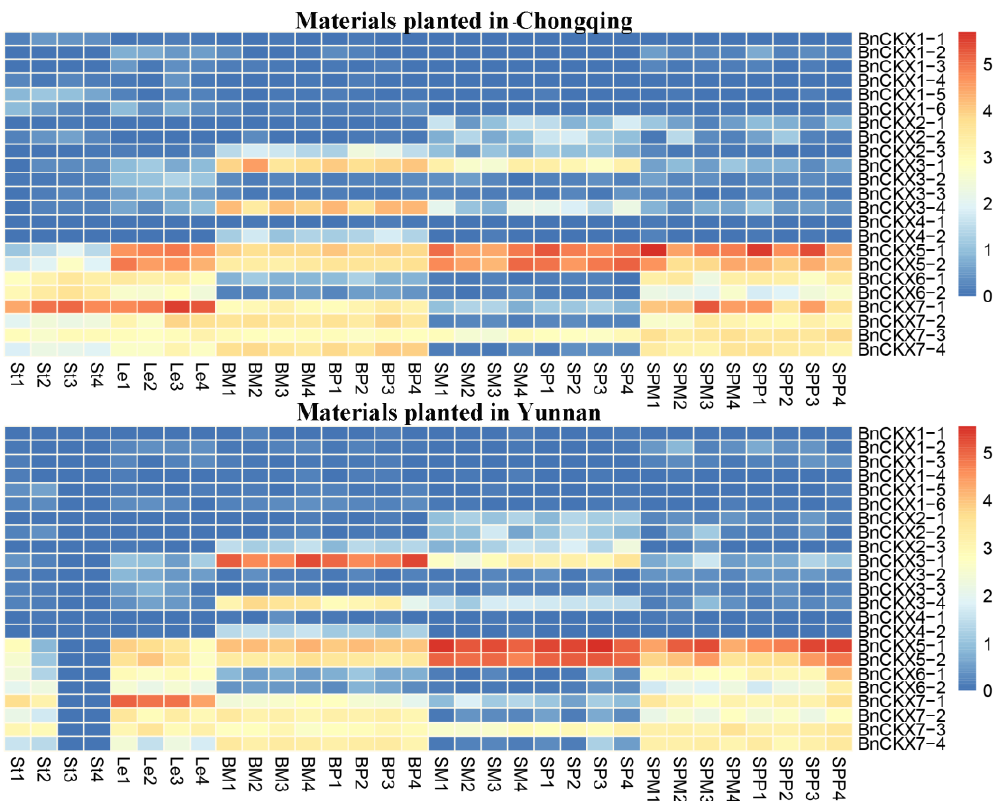
Figure 5. Heatmaps of the expression patterns of the 23 BnCKX genes in eight B. napus organs in two environments. The expression data were obtained from publically available RNA-sequencing (RNA-seq) data. Le: mature leaves; St: stems; BP: buds on the primary branch; BM: buds on the main stem of the inflorescence; SM and SP: seeds on the main stem of the inflorescence and primary branch, respectively; SPM and SPP: silique pericarps on the main stem of the inflorescence and primary branch, respectively; 1: materials with high yields and low harvest indices; 2: materials with low yields and high harvest indices; 3: materials with high yields and high harvest indices; 4: materials with low yields and low harvest indices.